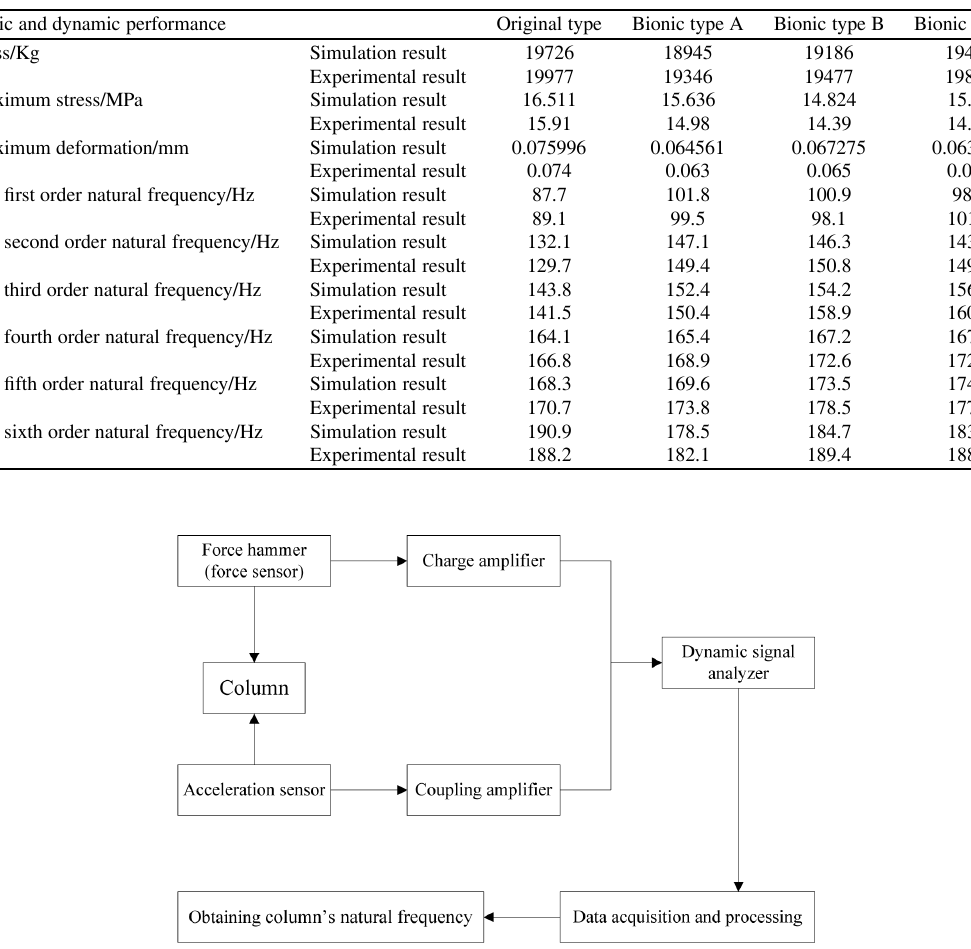
Table 4 Contrast between fi nite element analysis results and experiment results